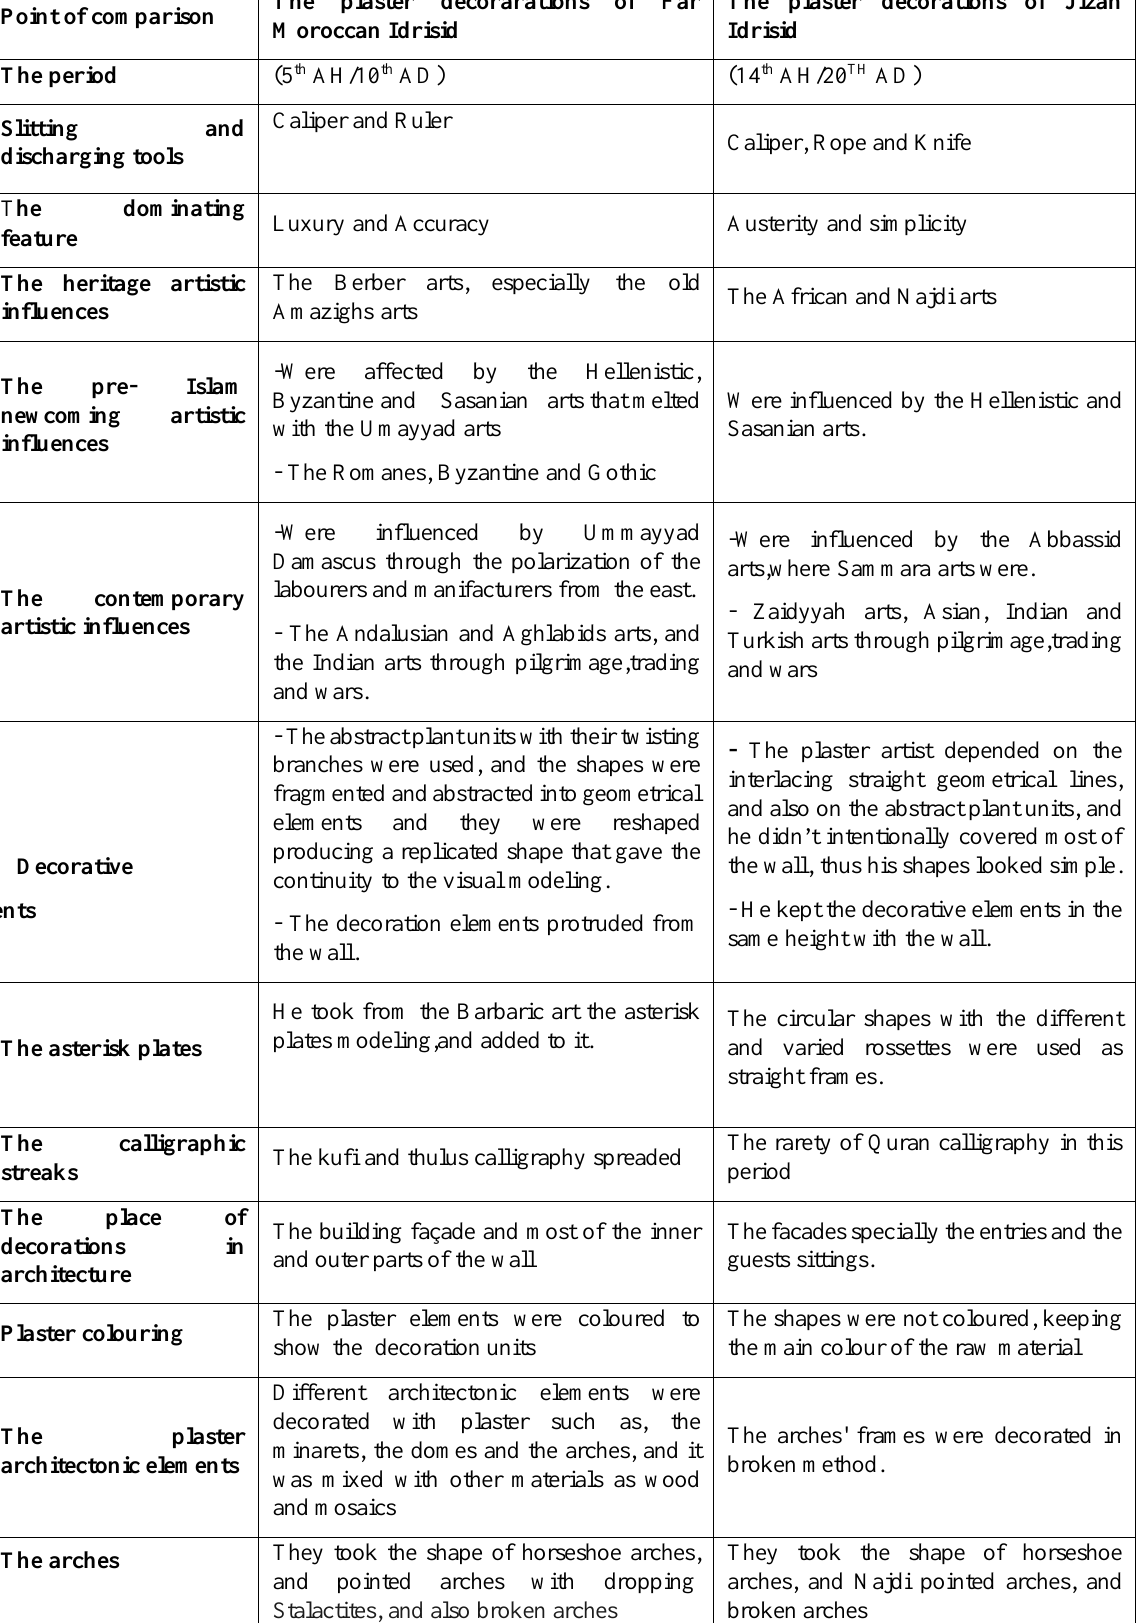
The results: The spirit of the Idrisis’ beginning headed from the south of the Arabian Peninsula towards Far Morocco, bearing its culture and its Najdi heritage arts with it, and established its basis in Far